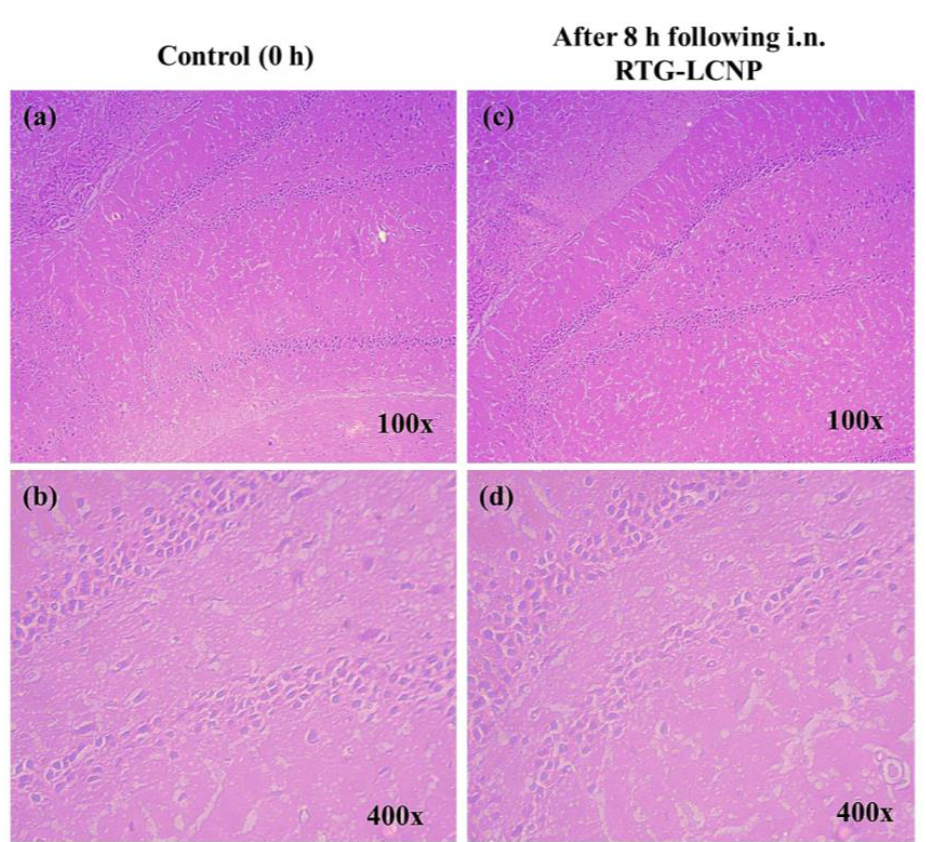
Figure 9. Histopathological evaluations of brain (hippocampal region) in different conditions: ( a ) Control animal at 100X magnification, ( b ) control animal at 400X magnification, ( c ) LCNP treated animal at 100X magnification, and ( d ) LCNP treated animal at 400X magnification.